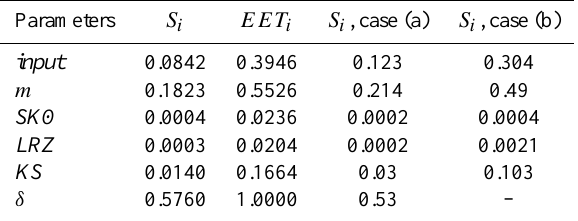
Table 3. Sensitivity analysis of the TOPMODEL: first two columns show the main effect sensitivity indices and the elementary effect tests for the initial calibration step. The third column shows the main effects for the pre-calibrated case discussed in Sect. 4.2.1, to reduce volatility of